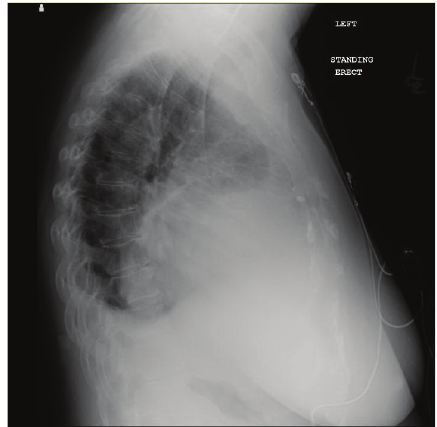
Figure 2: Lateral CXR showing cardiomegaly with loss of retroster- nal airspace.